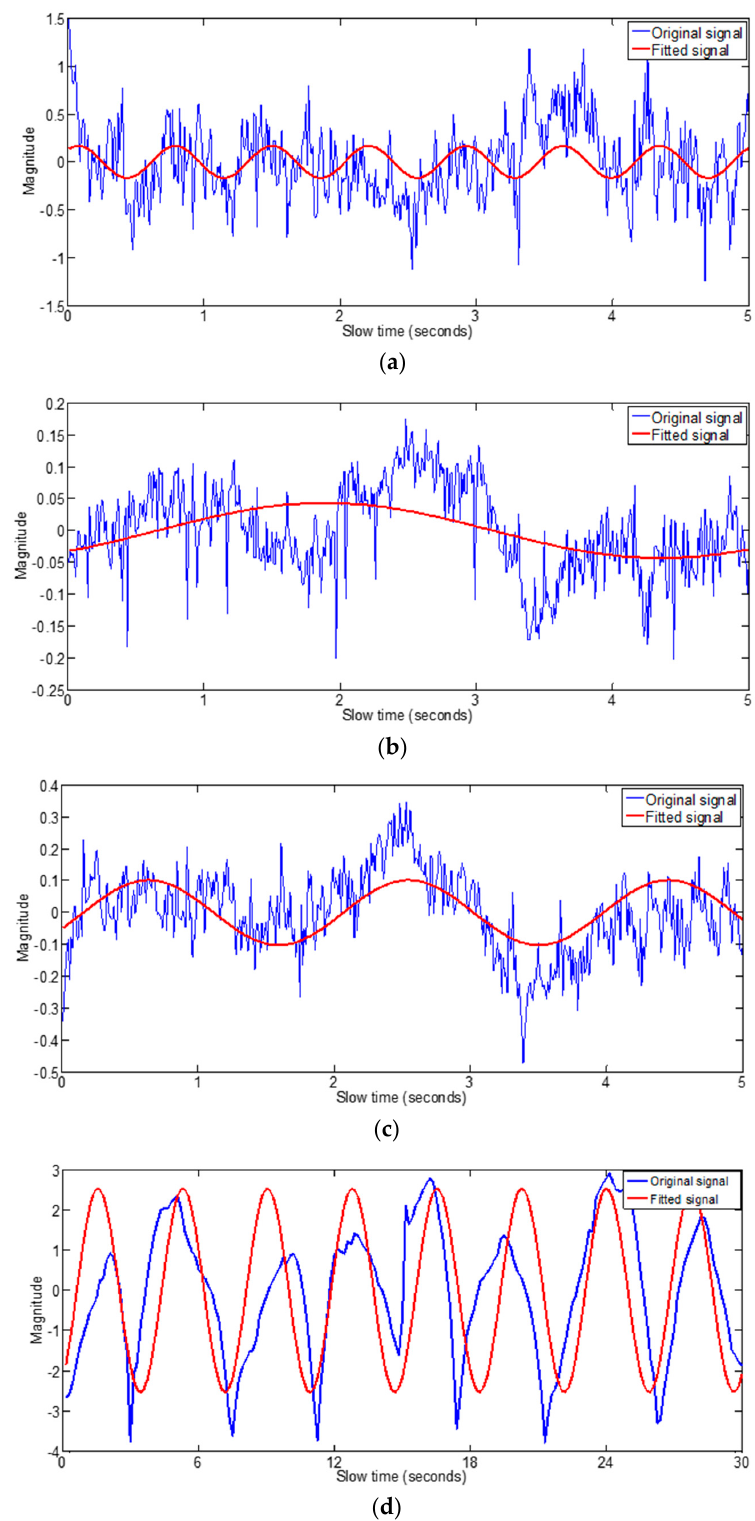
Figure 4. Data fitting algorithm results ( a ) fitting frequency higher than the respiration frequencies range ( b ) fitting frequency lower than the respiration frequencies range ( c ) fitting magnitude less than vital signal threshold ( d ) fitting signal for signal having information of vital signs.